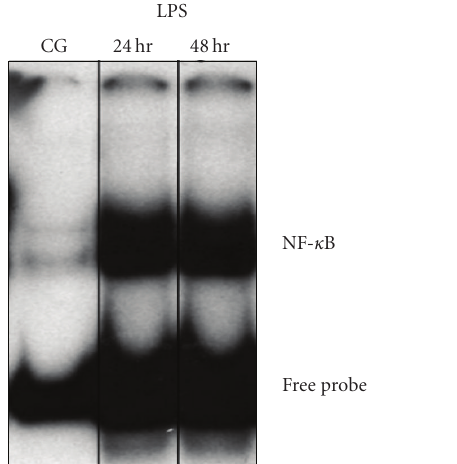
Figure 3: Activation of NF- κ B by EMSA. NF- κ B activity of macrophage in control and LPS groups (at 24, 48 hours).